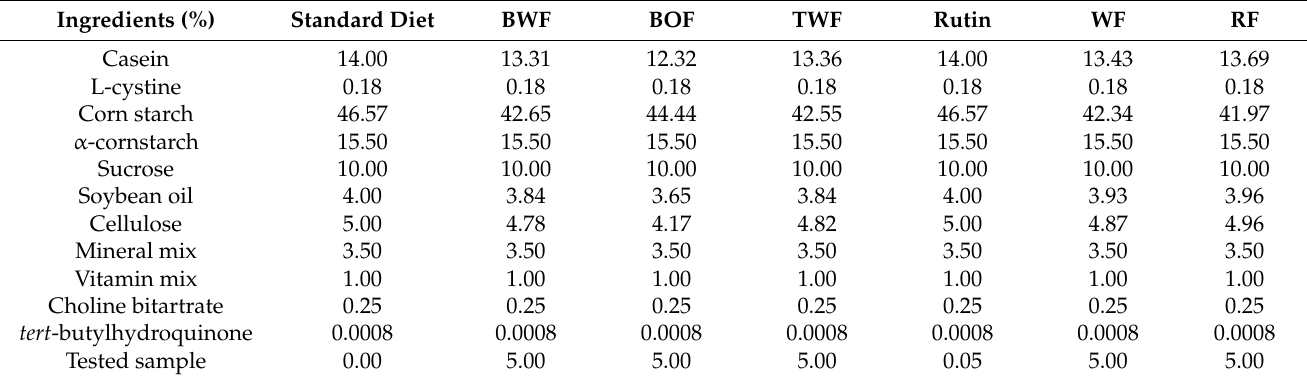
Table 2. Composition of standard and experimental diets used in the Study